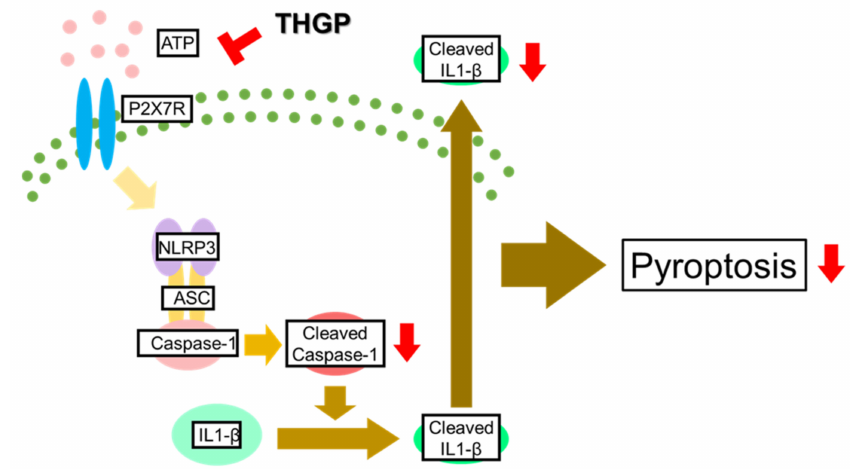
Figure 5. Mechanism by which THGP inhibits inflammasome activation induced by LPS/ATP. THGP suppresses the activity of Caspase-1 and the secretion of IL-1 β by complexing with ATP in the presence of LPS/ATP. THGP also suppresses LPS/ATP-induced